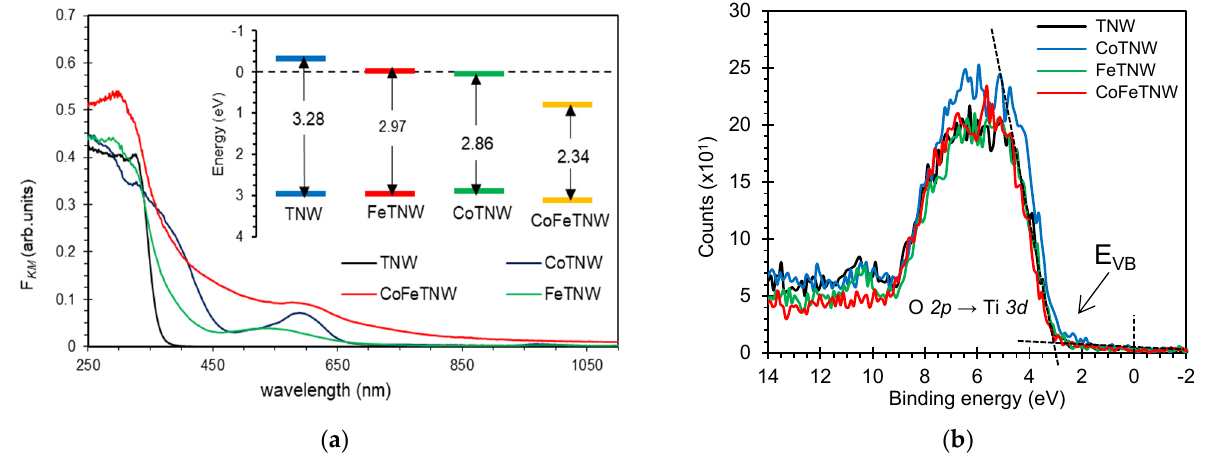
Figure 3. ( a ) Optical absorption with correspondent energetic diagram (as inset) and ( b ) XPS valence band spectra of the prepared samples.